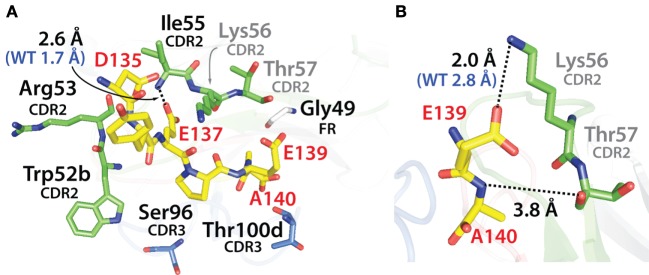
Analysis of the contributions of the acquired mutations in the N2.12 VHH antibody to enhanced affinity using computational models of the antibody–antigen complex. (A) Model of the N2.12 VHH in complex with the α-synuclein peptide. The six acquired CDR mutations are highlighted in black text, the wild-type residues are shown in gray, the nitrogen atoms are shown in blue, and the oxygen atoms are shown in red. Only one of the CDR mutations (Ile55) makes direct contact with the antigen, and the distance of this interaction is increased relative to wild type. (B) New or enhanced interactions between the N2.12 VHH and the α-synuclein peptide. Direct electrostatic interactions are shown with black dotted lines, and the distances are indicated in black for N2.12 relative to the original distances for wild type in blue (if there was a wild-type interaction). VHH residues are numbered according to Kabat.